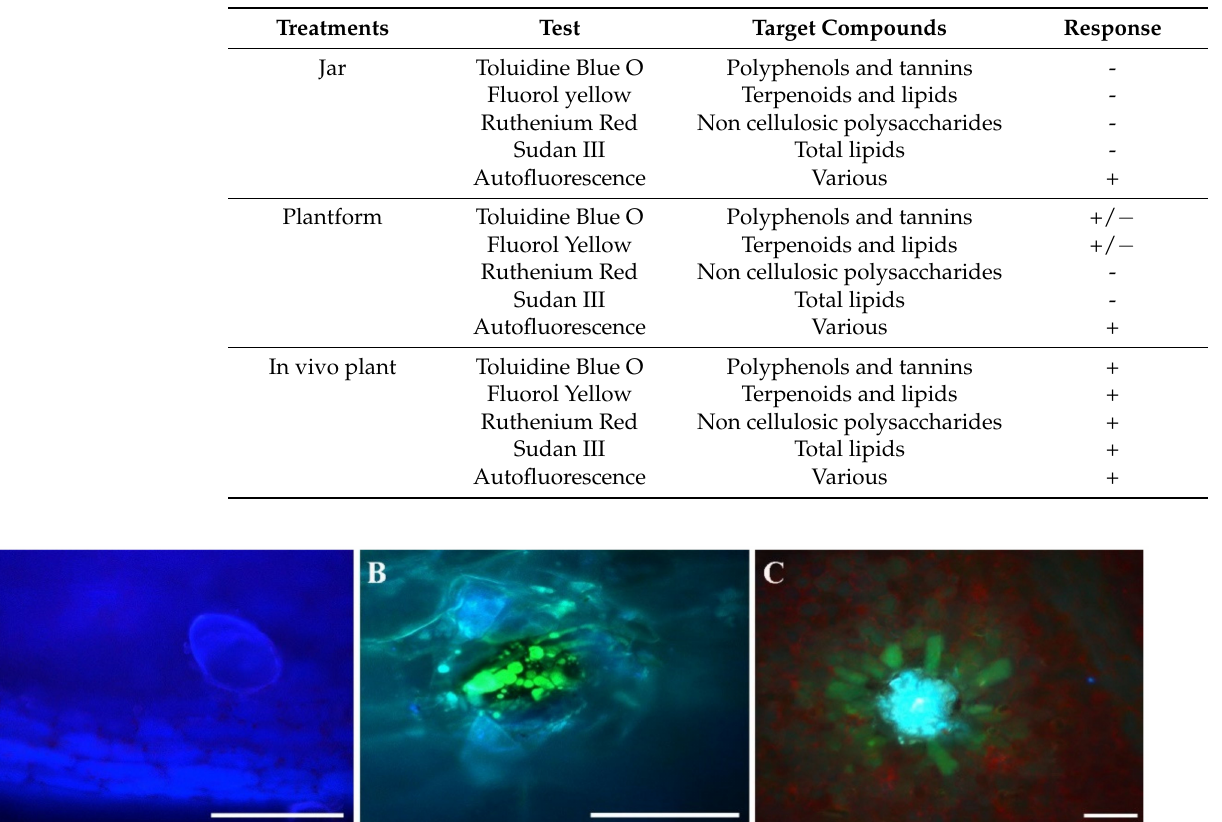
Table 4. Histochemical analyses performed on leaf samples from the different treatments.